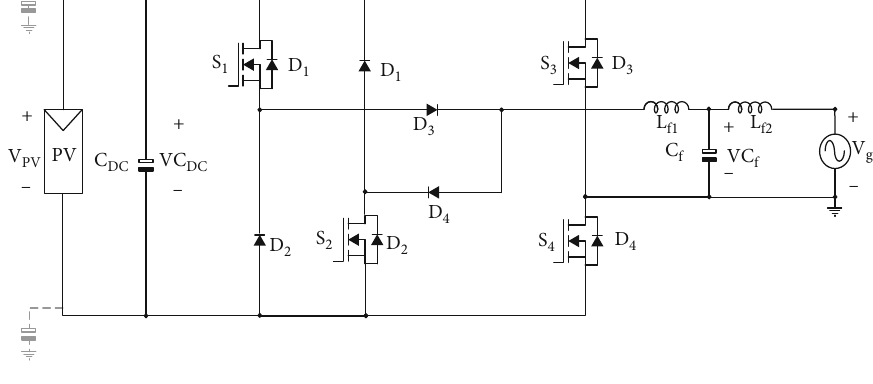
Figure 1: Full-bridge inverter.